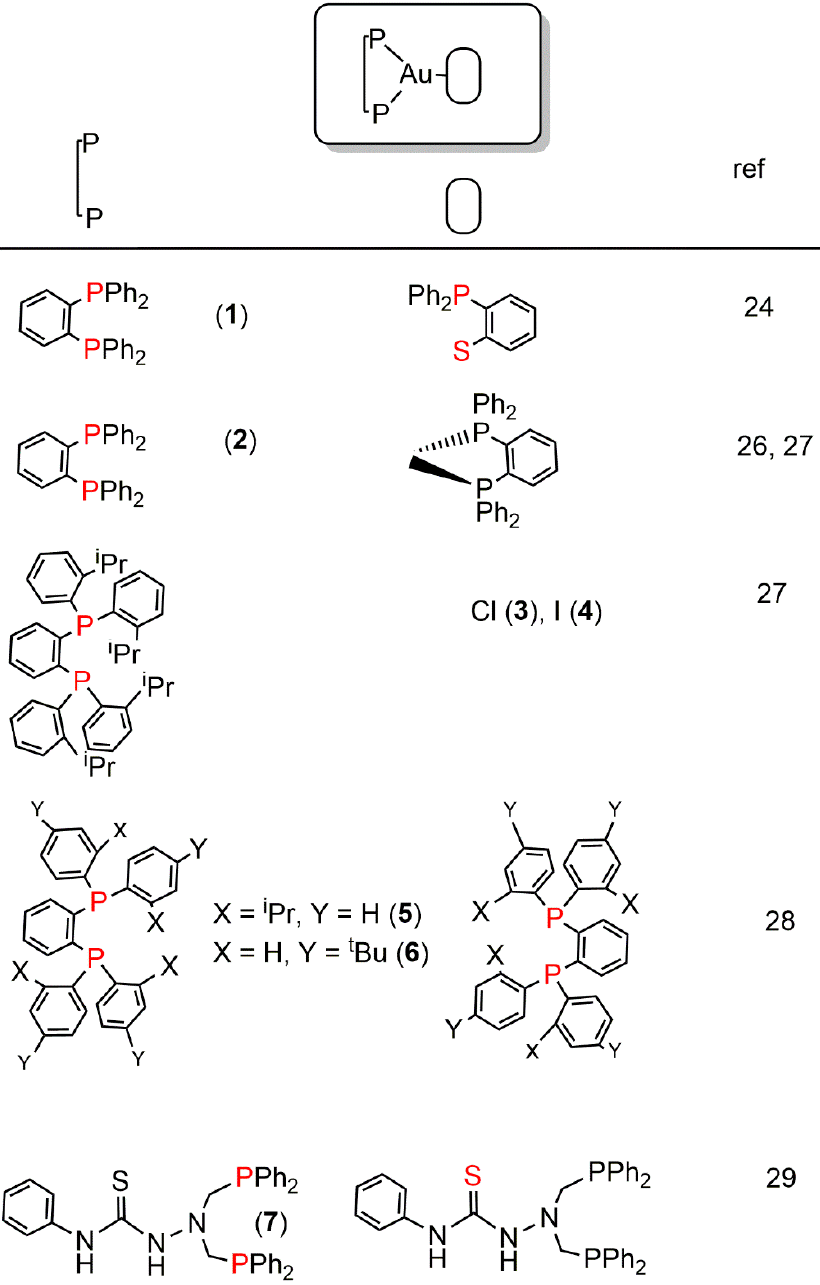
Figure 3. Chemical structure of diphosphine-Au(I) derivatives that display TADF properties. Coordinating atoms are marked in red.